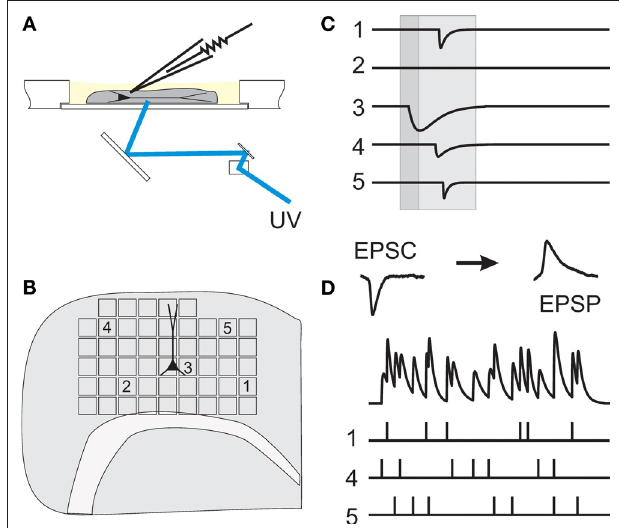
FIGURE 1 | Working principle of dynamic photo stimulation. (A) Glutamate is released in the tissue from its caged precursor by means of a short light pulse, entering the recording chamber from below. The beam position is controlled by two fast galvanic mirrors. (B) In order to fi nd suitable stimulation sites, i.e. locations within the slice that contain somata of neurons functionally connected to the intracellularly recorded cell, the tissue was scanned with single light pulses applied on a rectangular grid prior to dynamic stimulation. (C) To identify presynaptic locations, postsynaptic current responses to single-shot stimulations are detected in voltage clamp recordings of the postsynaptic cell. (D) To generate spatio-temporal input patterns of synaptic input, presynaptic sites are stimulated in rapid succession, which leads to overlapping postsynaptic potentials in current-clamp